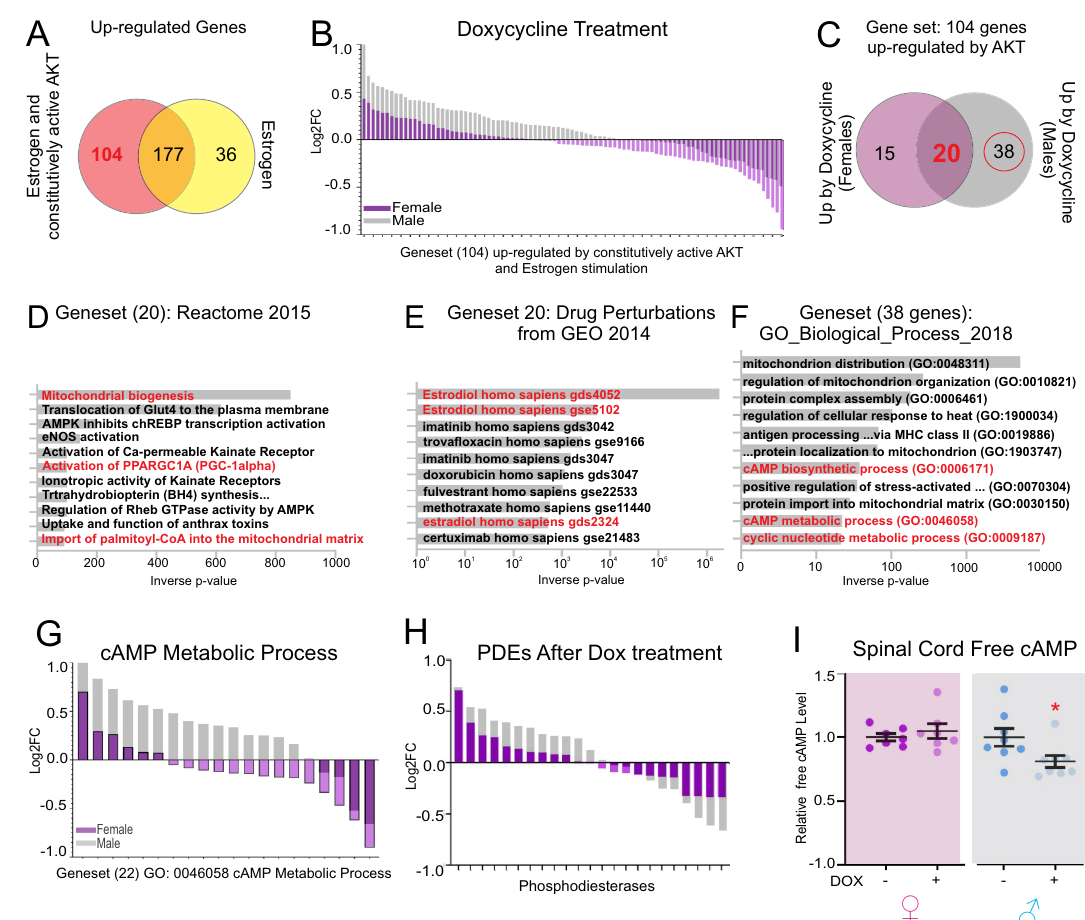
Figure 4. Doxycycline modulates cAMP related processes in males but not female mice. ( A ) Analysis of upregulated genes reported by Bhat-Nakshatri et al. 20 . ( B ) Differential gene expression of genes in the gene set identified in panel ( A ) (104 genes) following treatment with doxycycline. ( C ) Analysis of the genes upregulated by doxycycline treatment in the gene set identified in panel ( A ). ( D ) Reactome analysis of the 20 genes found in panel ( C ) that were commonly up-regulated by females and males following doxycycline treatment. ( E ) Drug perturbation signature analysis of the 20 genes found in panel C that were commonly up-regulated by females and males following doxycycline treatment. ( F ) Gene Ontology analysis of the 38 genes identified in panel ( C ) that were uniquely up-regulated by doxycycline in male mice. ( G ) Differential gene expression of genes in GO:0046058 in female and male mice following doxycycline treatment. ( H ) Differential gene expression of genes encoding phosphodiesterases in female and male mice following doxycycline treatment. ( I ) ELISA detecting free cAMP in spinal cord lysates from female (n = 4) or male (n = 4) with or without doxycycline treatment (n = 4 mice per group with 2 technical replicates per animal). * p < 0.05 by two-tail student’s